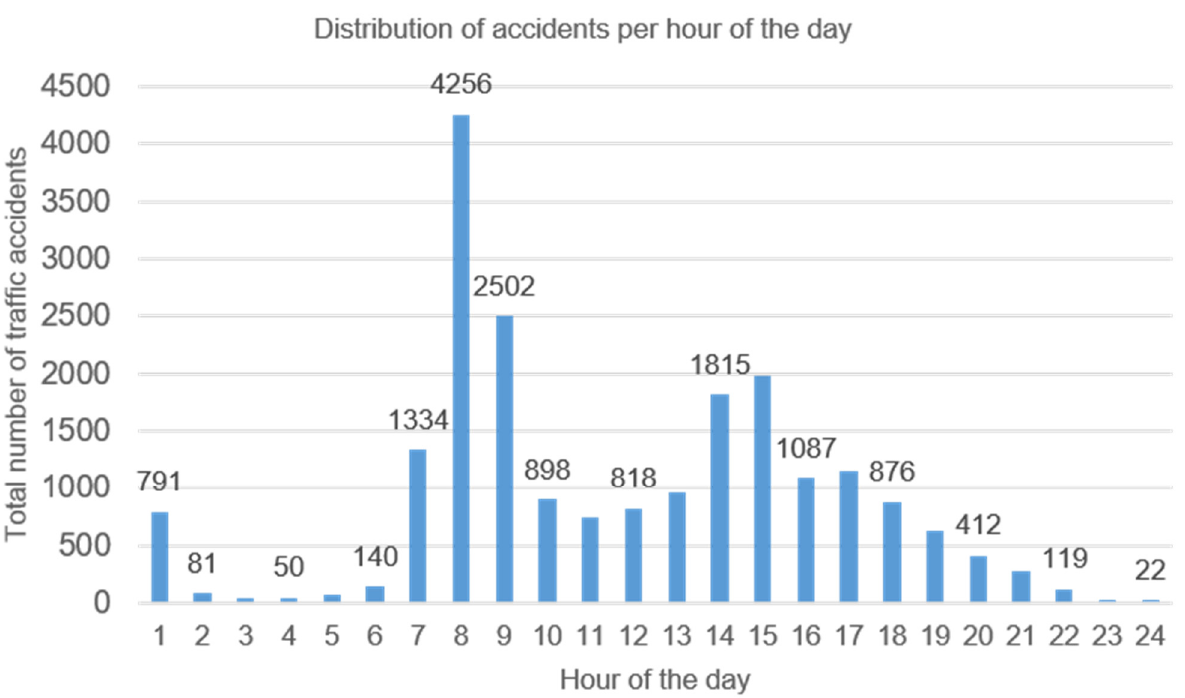
Figure 2. Distribution of total number of accidents analyzed, according to the hour of the day.